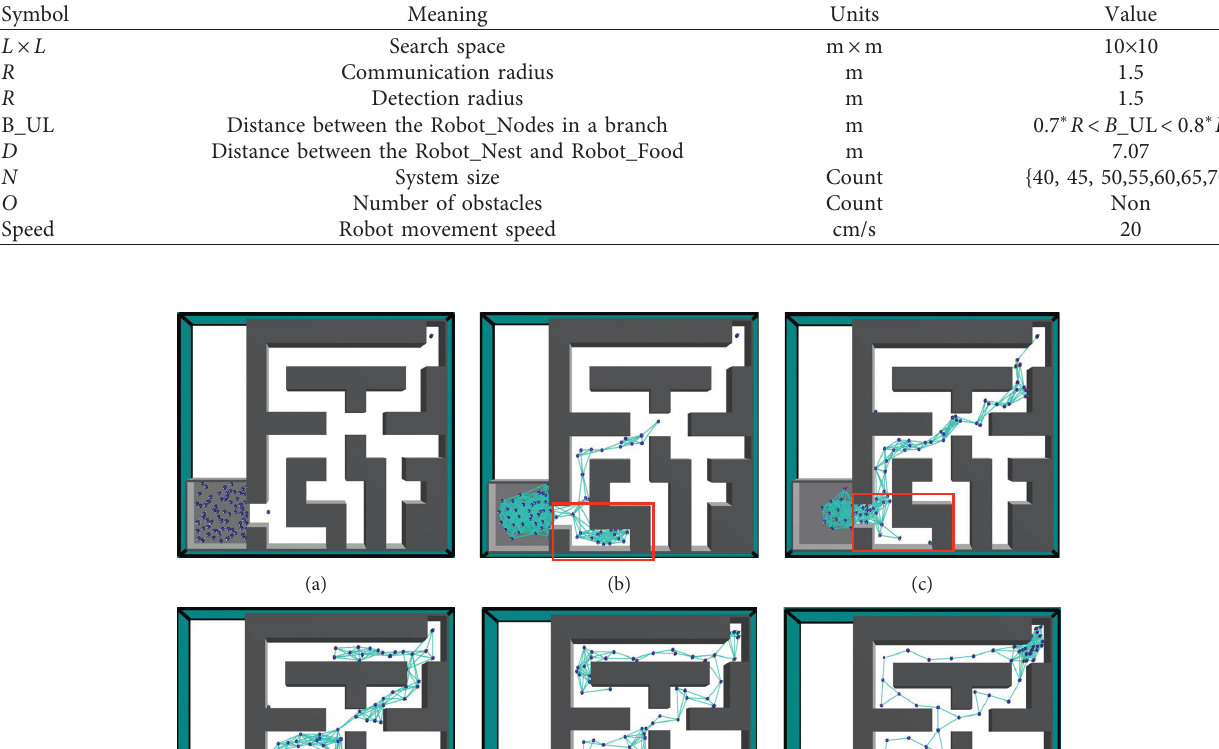
Table 1: Parameter settings for simulation experiments in a maze arena.